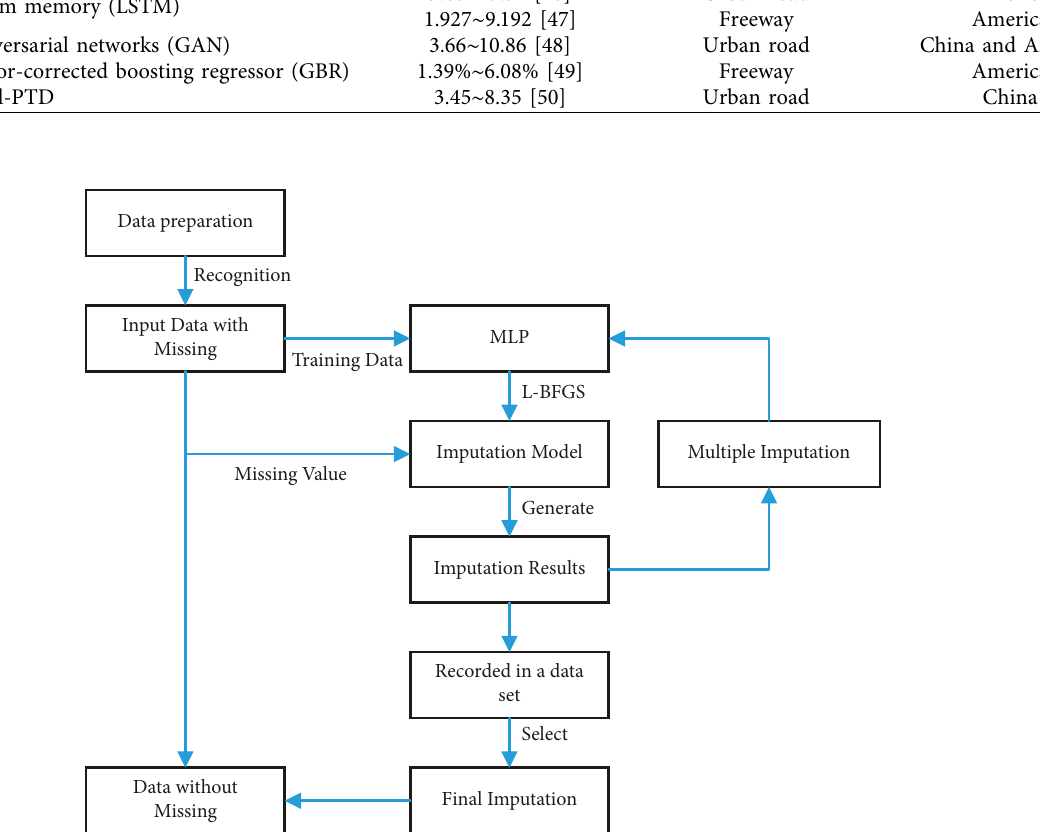
Figure 1: Overall structure of the model.